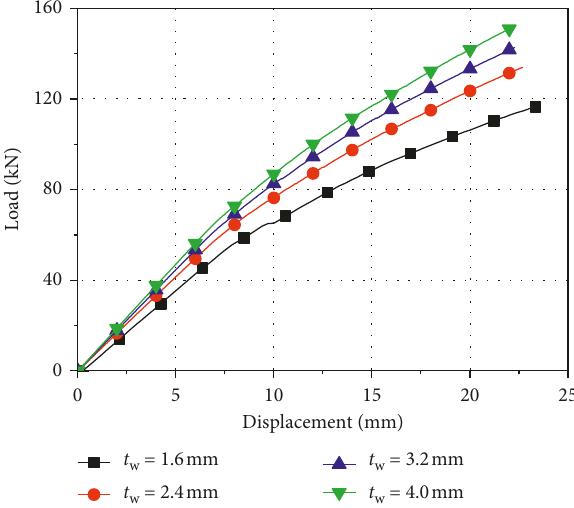
Figure 14: Effect of the lattice-web thickness ( h 75mm, t s 1.6mm, and ρ 60 kg/m 3 (cid:30) (cid:30)